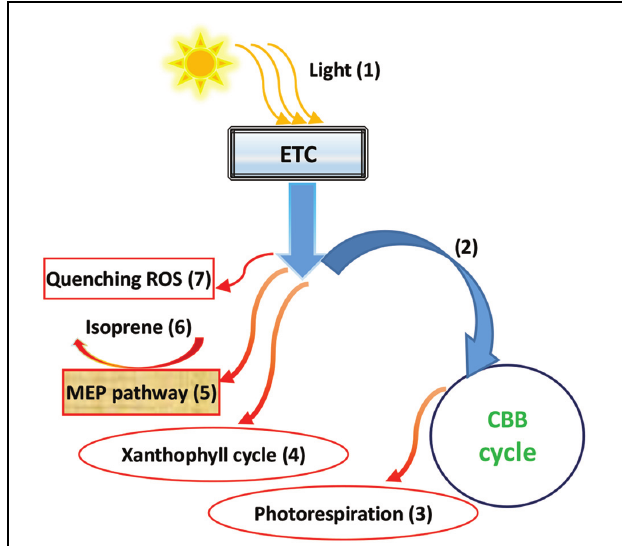
FIGURE 3 | A diagrammatic representation of isoprene biosynthesis downregulation in response to elevated CO 2 . Light energy from the sun (1) is transferred into the plant metabolic bioprocesses using an electron transport chain (ETC). Under elevated CO 2 , more electron flux may be used for the CBB cycle for photosynthesis (2), while less electrons may flow into the photorespiration cycle (3), xanthophyll cycle (4), and the methylerythritol 4-phosphate pathway (MEP), (5) to synthesize isoprene (6), as well as other redox reactions, including the quenchers of ROS (7) (based mainly on Morfopoulos et al.,